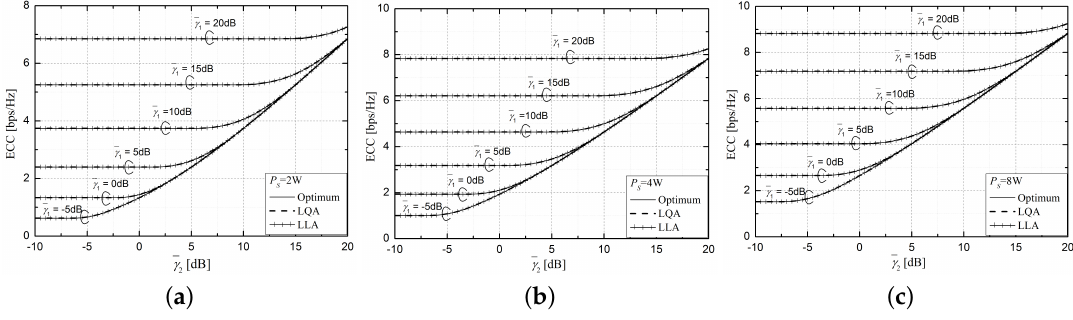
Figure 5. ECCs of the Co2P JDT network as a function of ¯ γ 2 [dB], with ¯ γ 1 [dB] as a